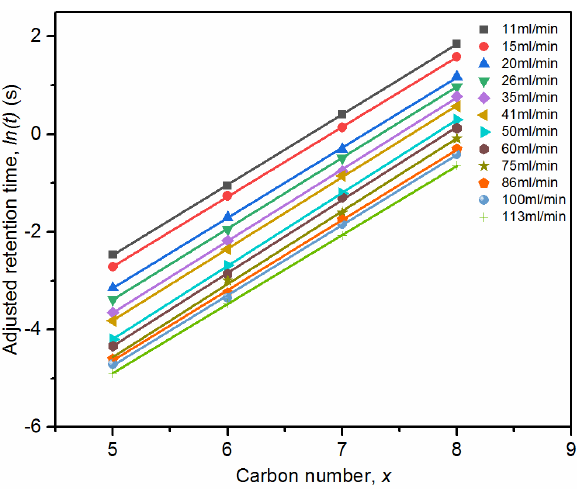
Figure 8: Adjustment retention time of probe molecules for sample N234